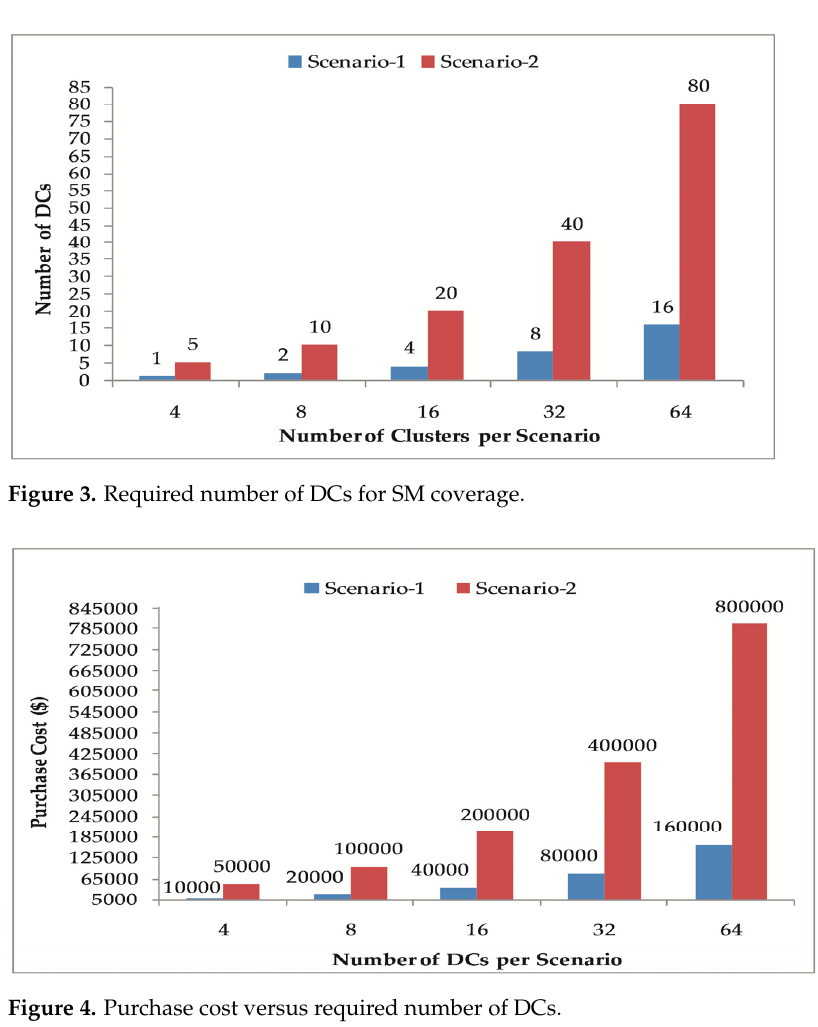
Table 5. Detailed configuration of simulation experiments. Figure 4. Purchase cost versus required number of DCs.